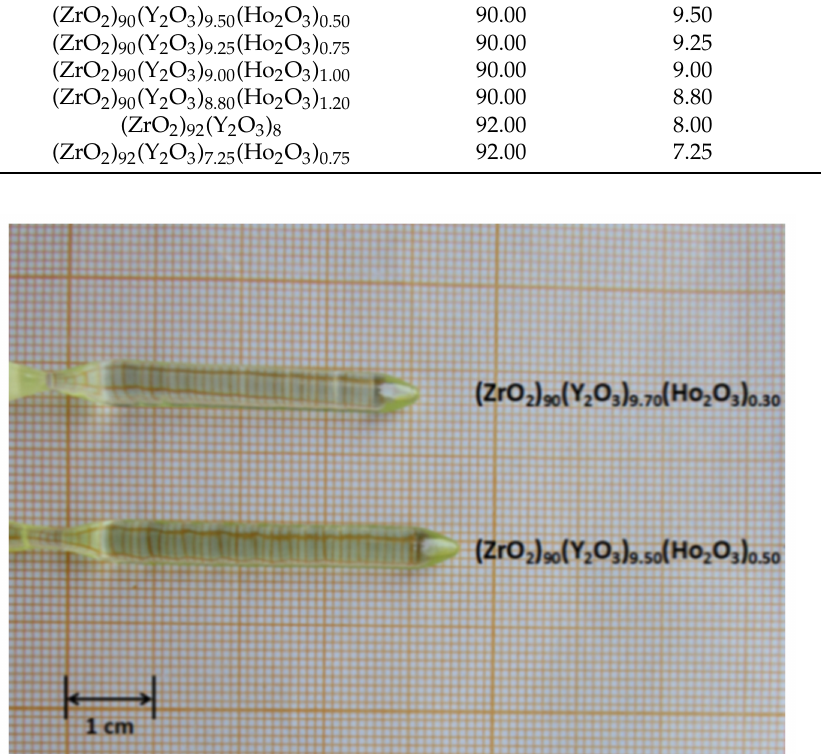
Figure 1. (ZrO 2 ) 90 (Y 2 O 3 ) 9.70 (Ho 2 O 3 ) 0.30 and (ZrO 2 ) 90 (Y 2 O 3 ) 9.50 (Ho 2 O 3 ) 0.50 crystal